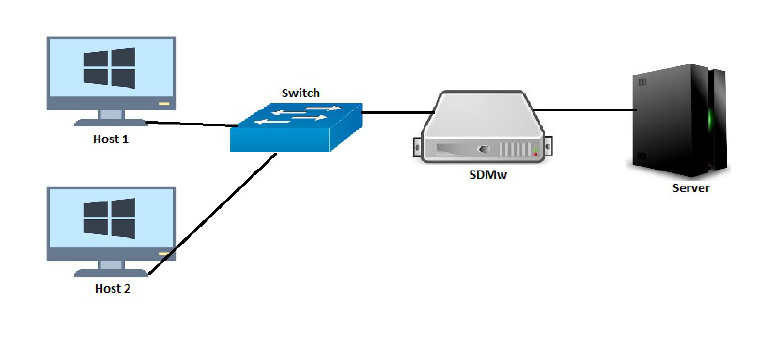
Figure 3. Secure Dynamic Middleware (SDMw) test bench